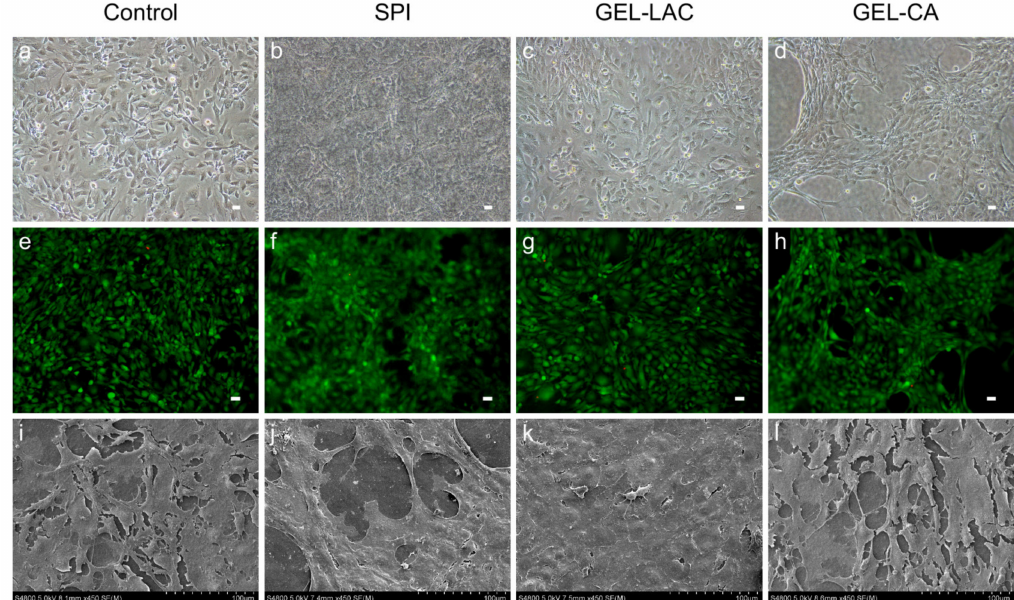
Figure 6. Culture of 3T3 cells above the films. ( a – d ) Contrast phase microscopic images of 3T3 cells on tissue culture well plate (control) and the films after 24 h of cell seeding; ( e – h ) representative Calcein AM/Ethidium homodimer-1 live/dead (CA-EthD1) assay images and ( i – l ) SEM images. ( a – h ) Images taken with 10 × magnification; scale bars correspond to 25 µ m. ( i – l ) Images taken with 450 ×